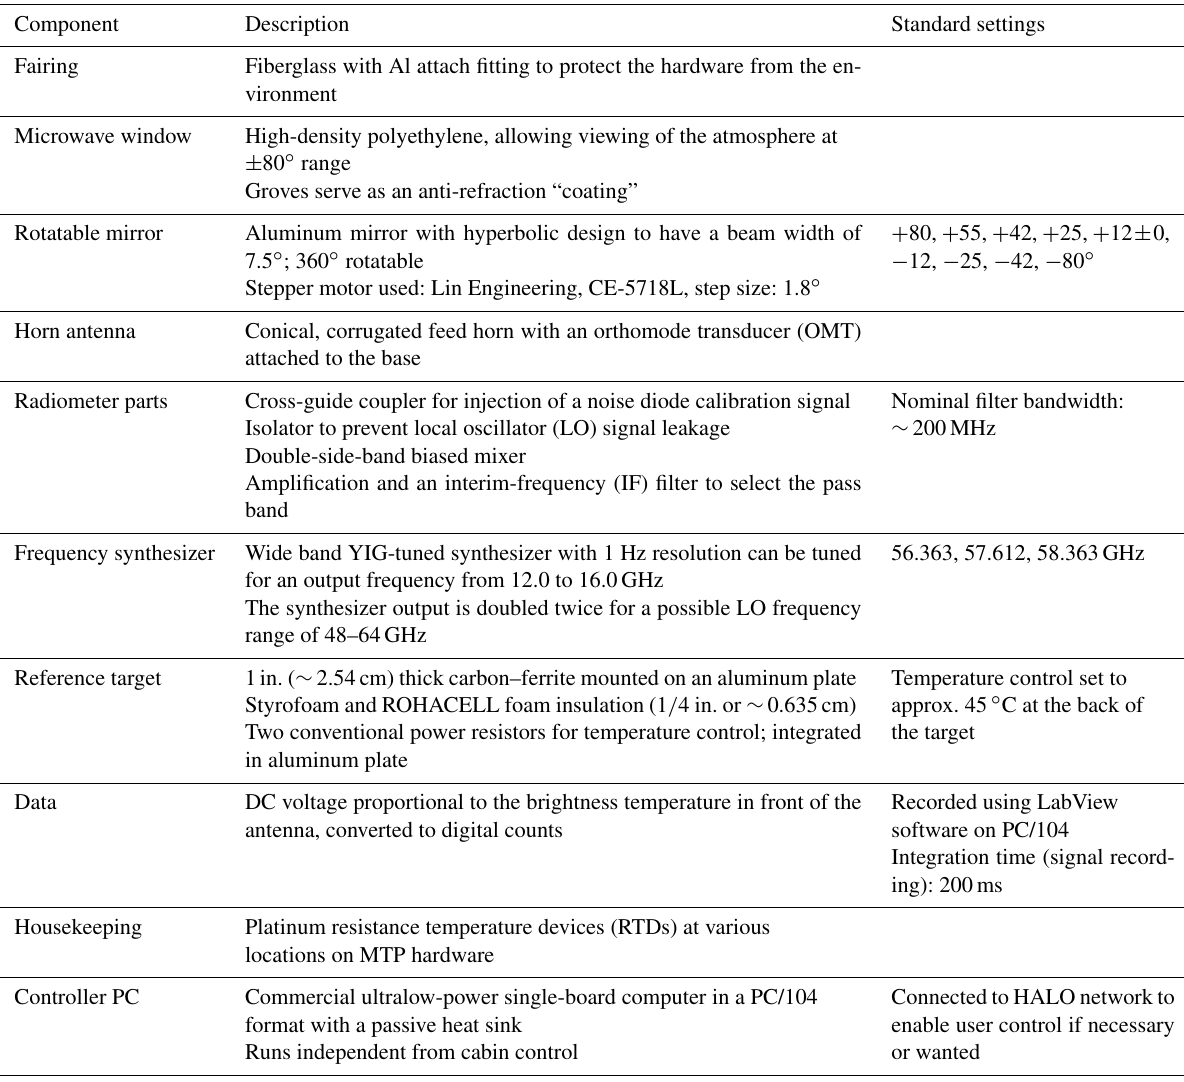
Table 1. MTP instrument: components and settings.